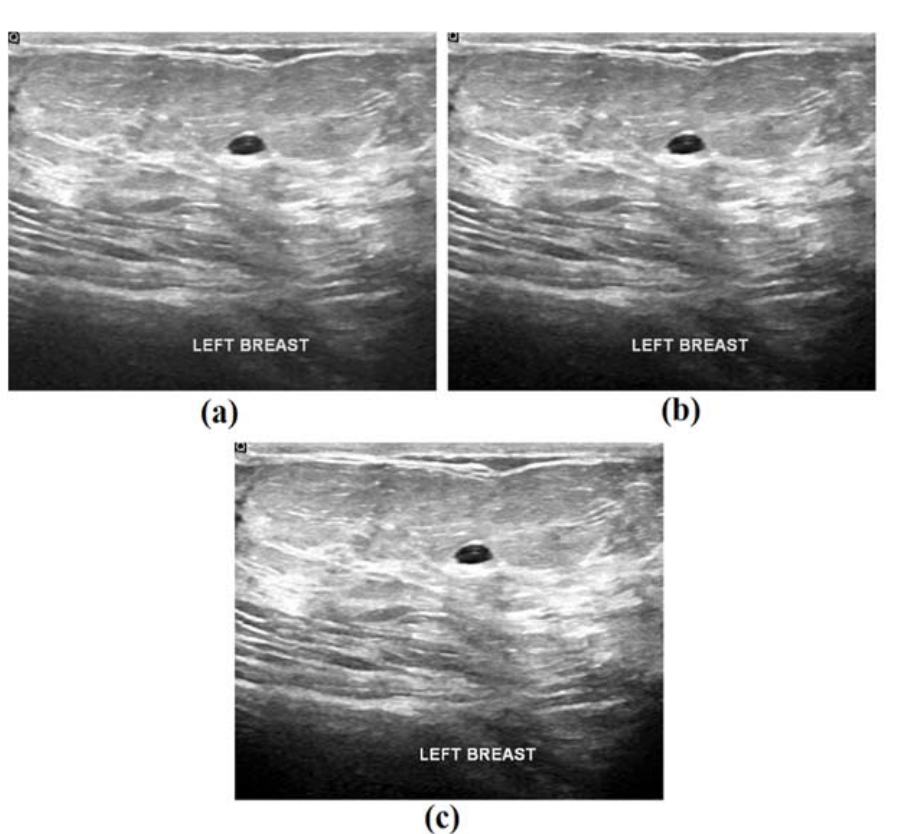
Figure 5. Sample visualization results: ( a ) original image; ( b ) noise ‐ removed image, and ( c ) contrast ‐ enhanced image.